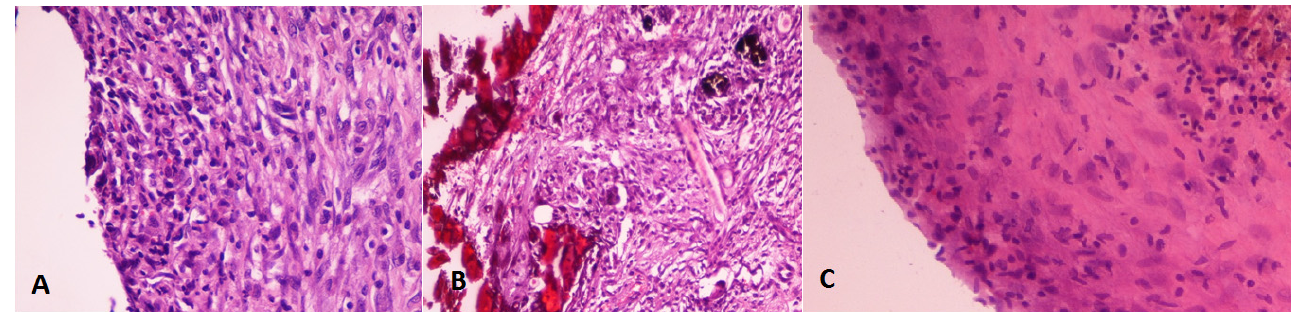
Figure 3. Type of cells predominant inflammatory response: lymphocytes, macrophages, and/or polymorphonuclear cells. Hematoxylin–eosin stain. ( A ): Theracal 15 days (40×). ( B ): MTA-G3 15 days (10×). ( C ): MTA 15 days (20×).